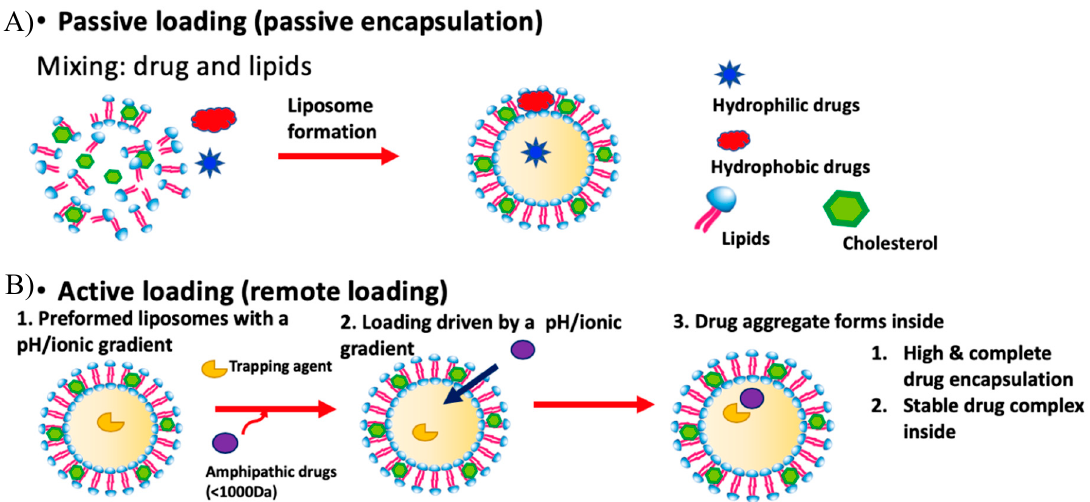
Figure 1. The two major methods for liposomal drug loading. ( A ) Passive loading involves co-current loading and liposomal formation. ( B ) In active loading, liposomes are formed containing a gradient used to load drugs.